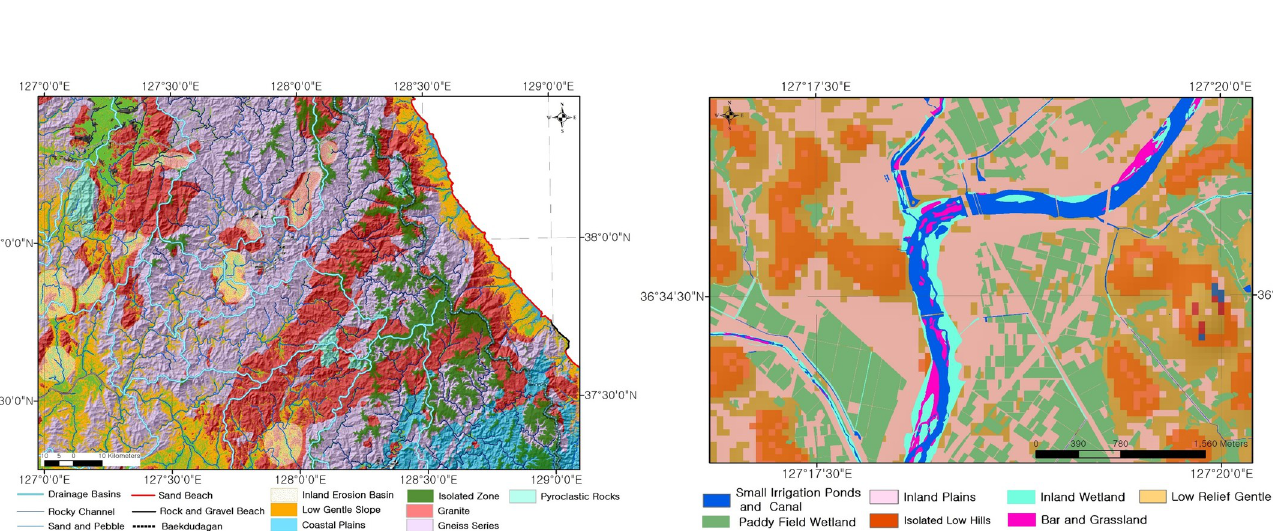
PLOS ONE | https://doi.org/10.1371/journal.pone.0259651 November5, 2021 10 /